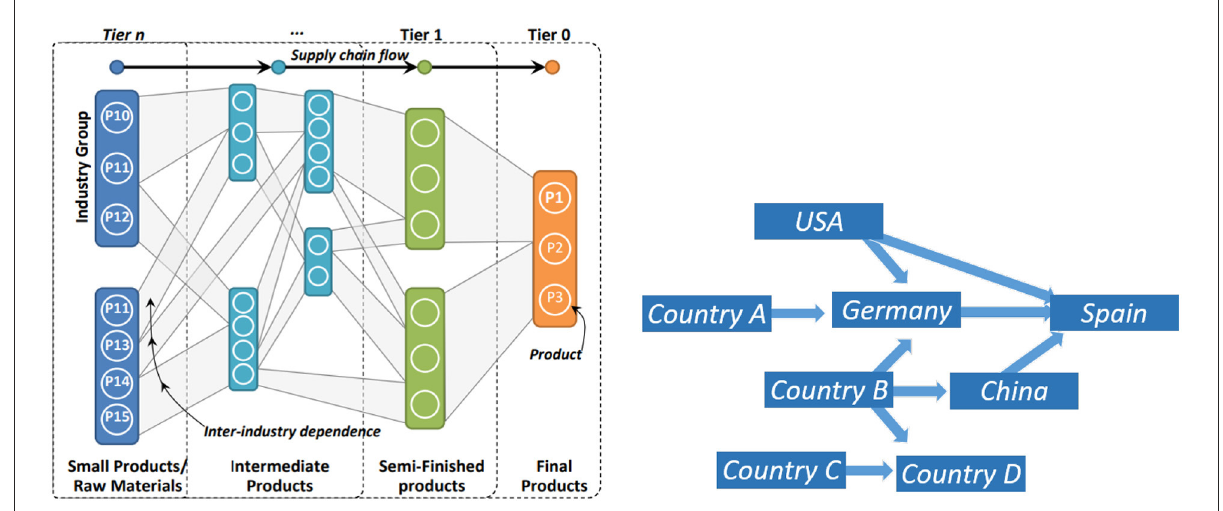
FIGURE1 Examples of product dependencies [ (A) on left] and trade networks [ (B) on the right] which are combined for the CyPEM hybrid